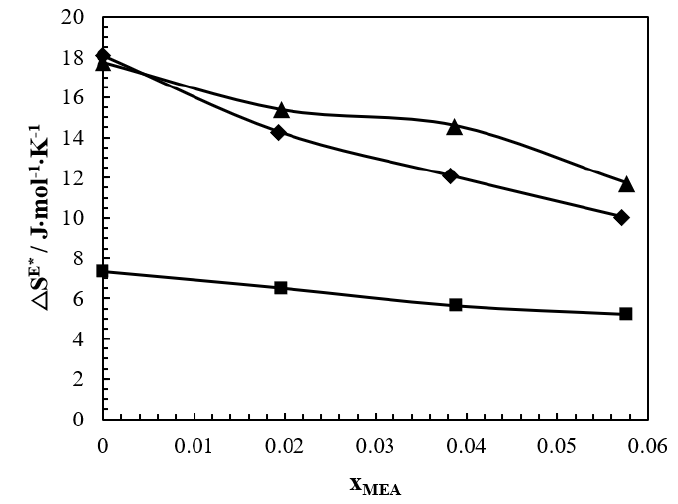
Figure 5. Excess entropy of activation ∆𝑆 𝐸∗ for the viscous flow of “ ◼ ”—MDEA + MEA + H 2 O, “ ◆ ”— DMEA + MEA + H 2 O, and “ ▲ ”—DEEA + MEA + H 2 O for a range of MEA mole